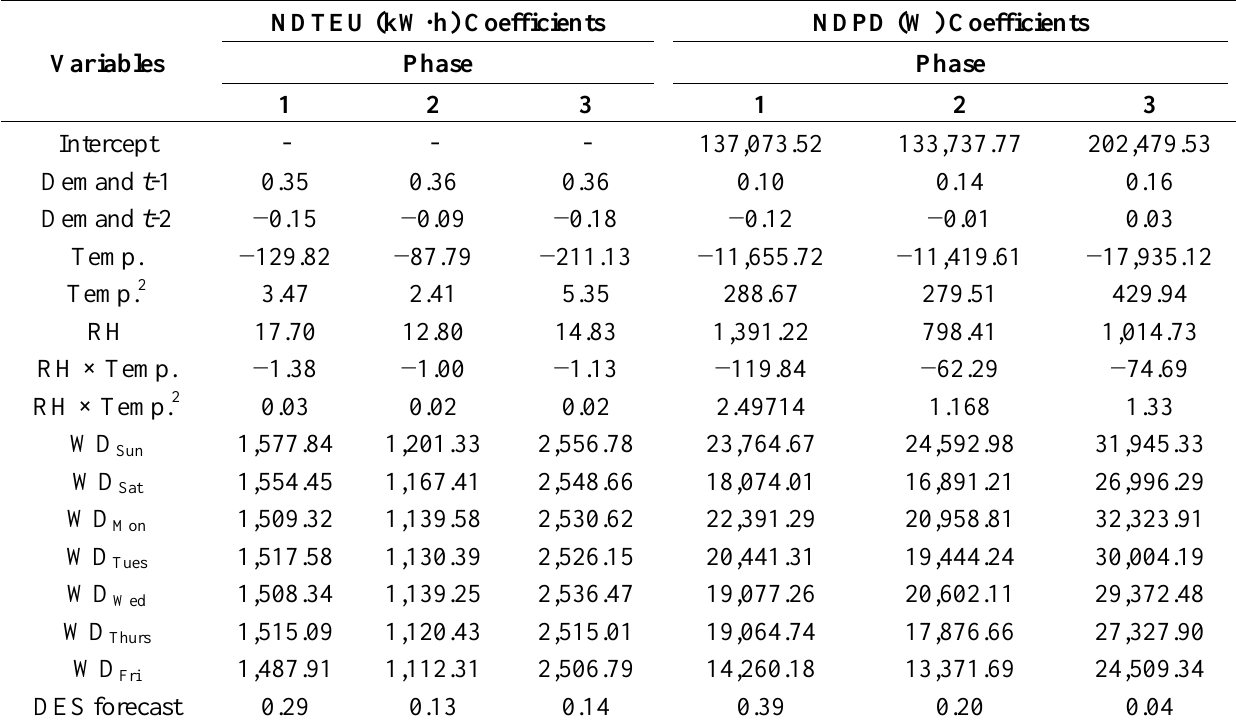
Table 1. ARIMAX coefficient estimates. NDTEU: next day total energy use; NDPD: next day peak demand; RH: relative humidity; and DES: double exponential